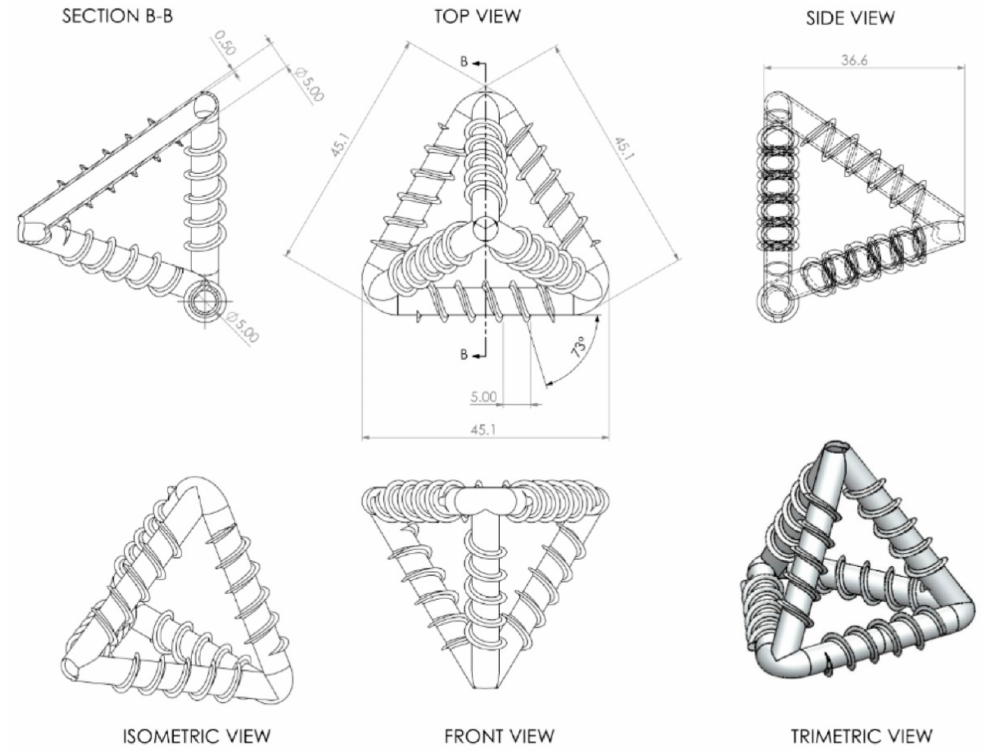
Figure 2. Mini-vascular networks (MVNs) of 3D-printed tetrahedral units (TETs) obtained from the authors of